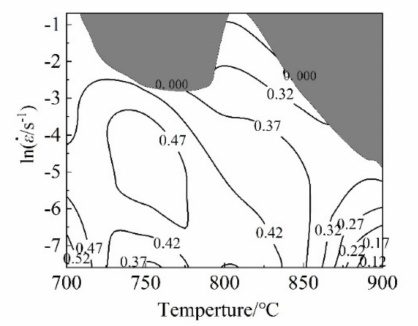
Figure 9. Hot working diagram of Ti-6Mo-5V-3Al-2Fe